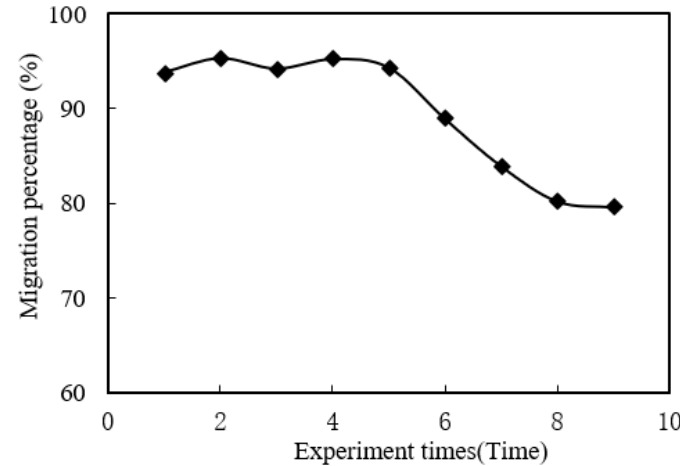
Figure 13. Reuse of organophosphonic liquid.